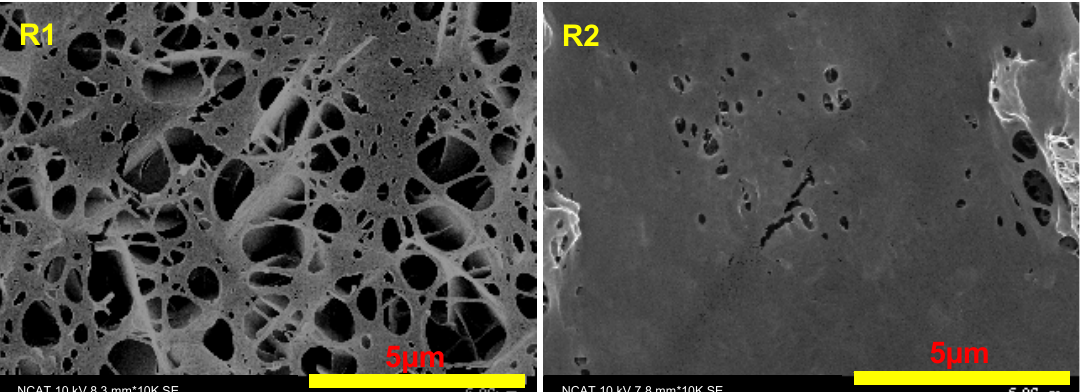
Figure 2. SEM images of collagen on pure Mg. Collagen stock solution was diluted by R1 ( Left ) and R2 ( Right ) extract solution and then coated on the pure Mg